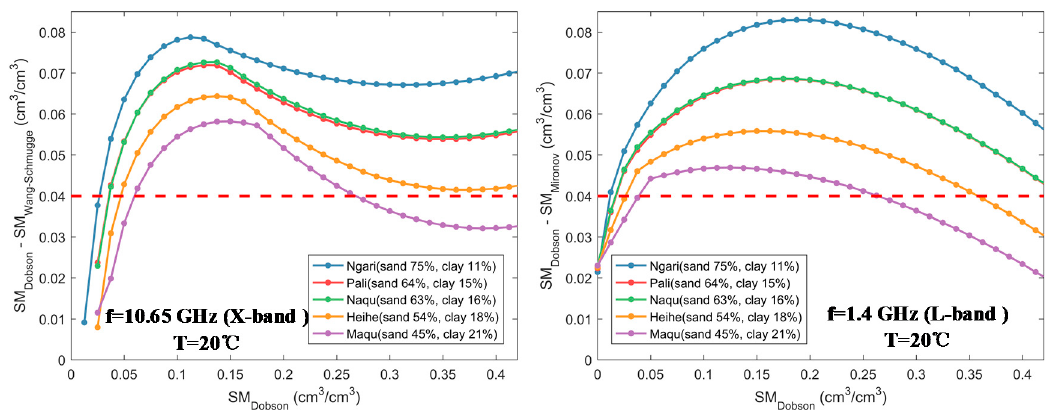
Figure 13. Effect of different dielectric constant models on the soil moisture retrieval accuracy (left: soil moisture retrieval differences between the Dobson and Wang–Schmugge models under X-band conditions; right: differences between the Dobson and Mironov models under L-band conditions).